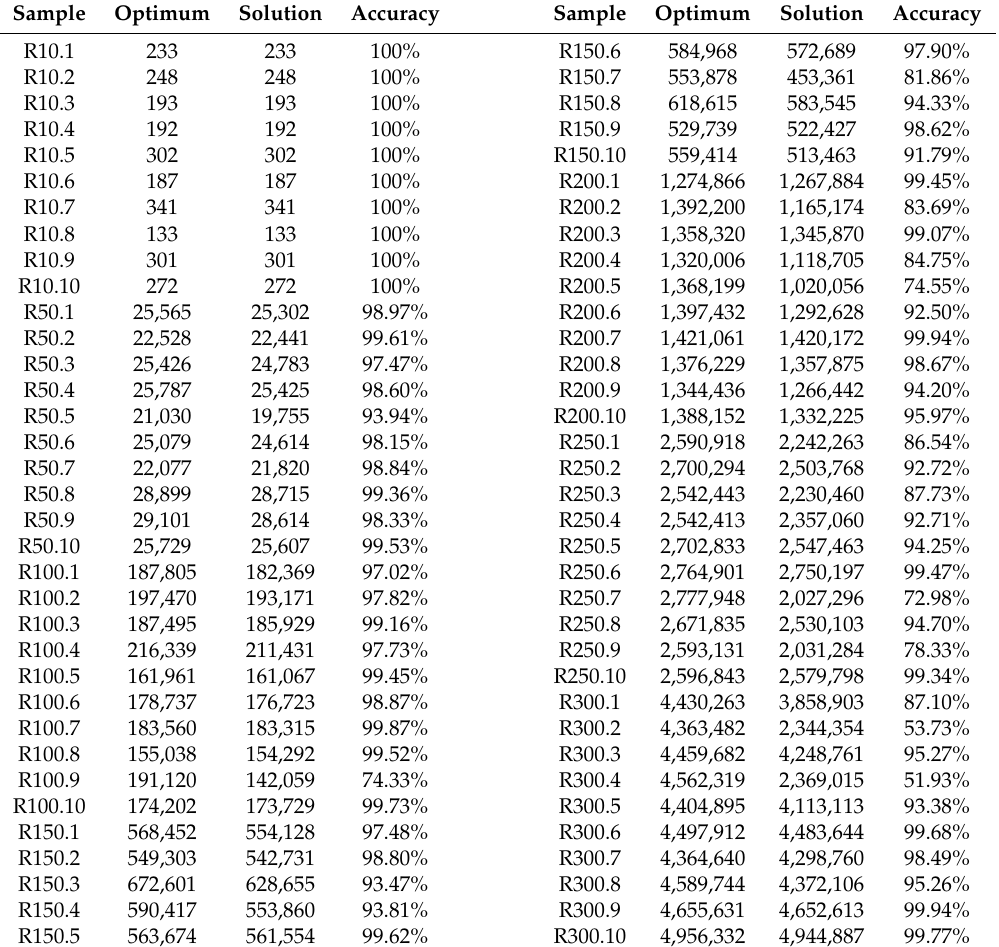
Table 4. Detailed solutions and accuracies for Max-cut problems with different dimensions by reinforcement learning